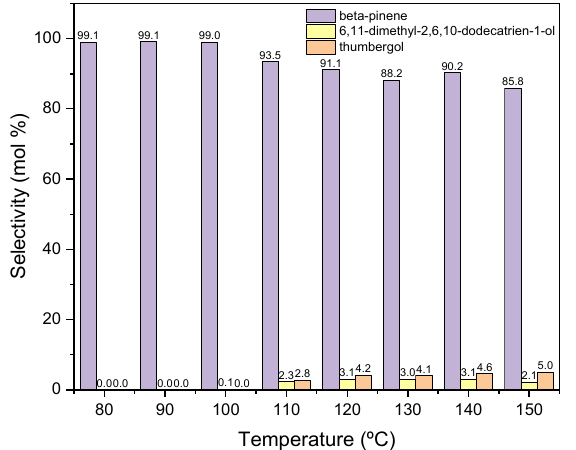
Figure 7. The influence of temperature on the selectivities of the appropriate products over diatomite as the catalyst.